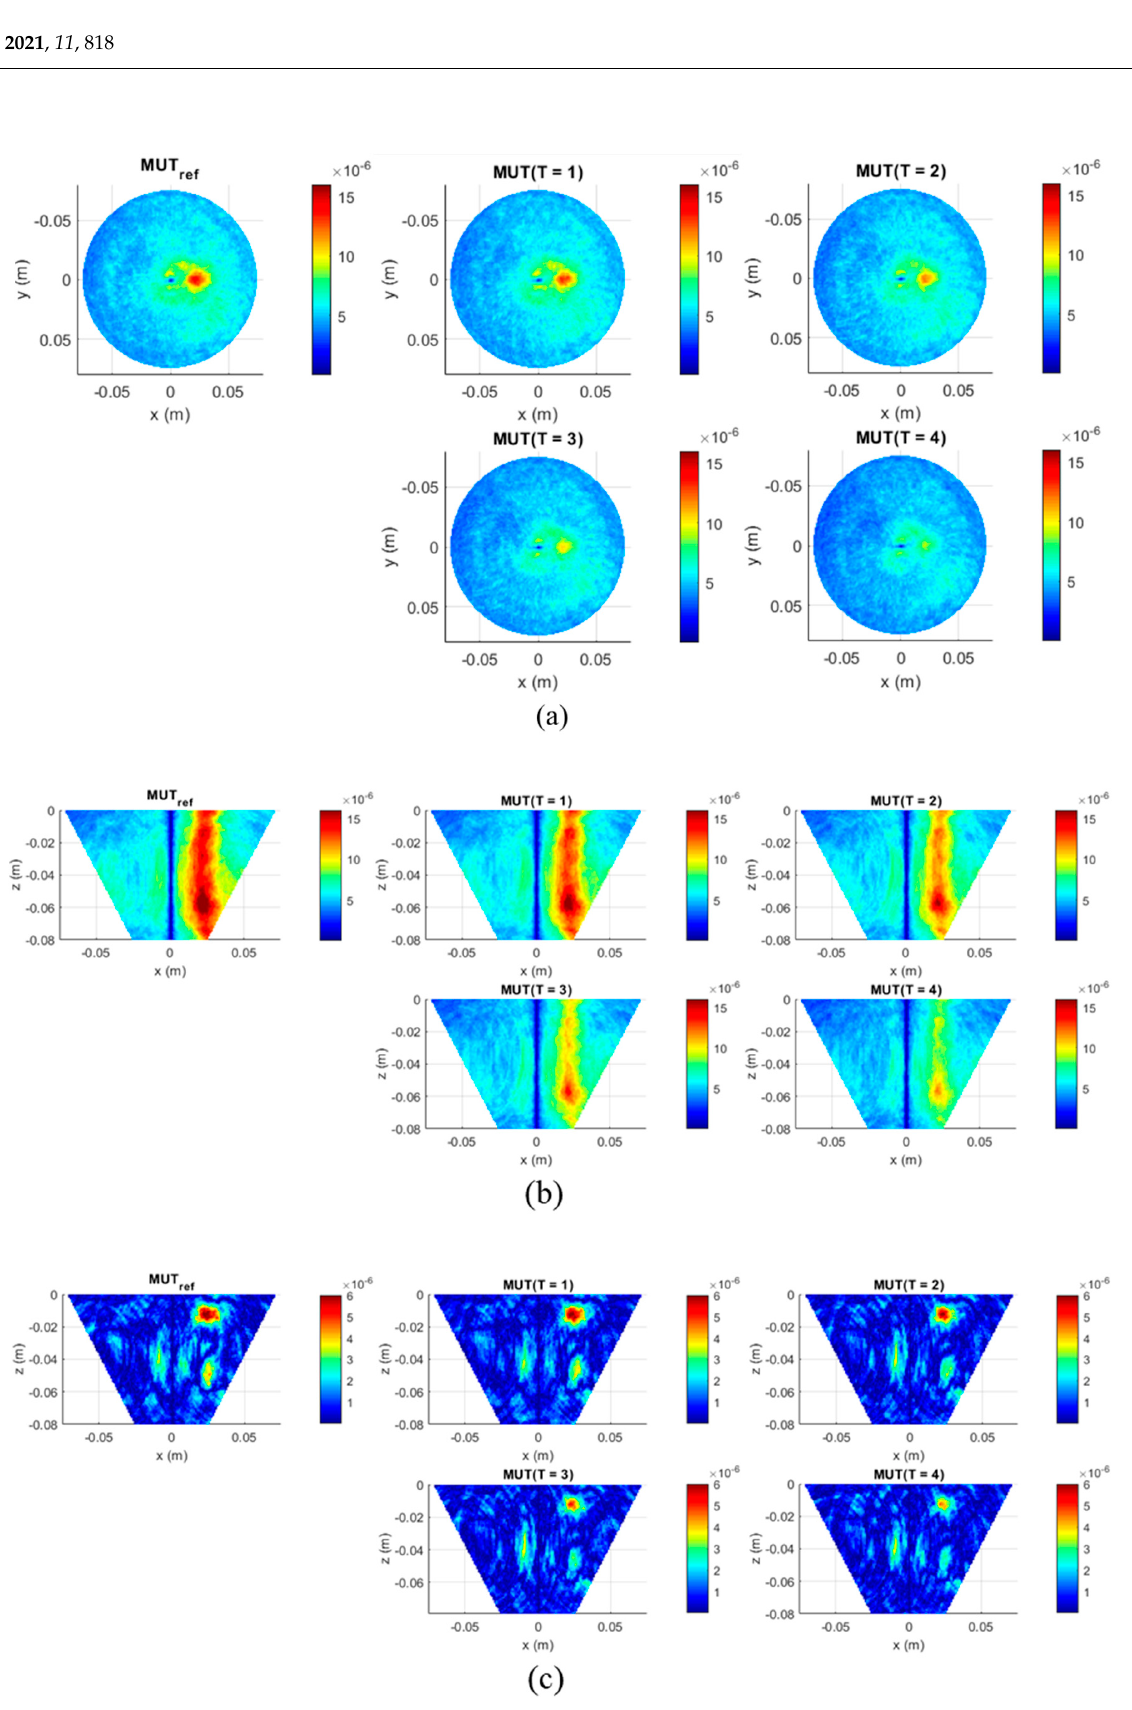
Figure 6. UWB images of the five phantoms demonstrating the correlation between intensity of the image I ( r 0 , T ) recon- structed via Equation (6) and the decreasing permittivity of the tumor imitate in ( a ) xy-slice, depth z = − 2 cm and ( b ) in xz-slice, y = 0. The magnitude of the common DAS imaging (Equation (4)) is shown in ( c ). Color bar represents the intensity of the image in the arbitrary